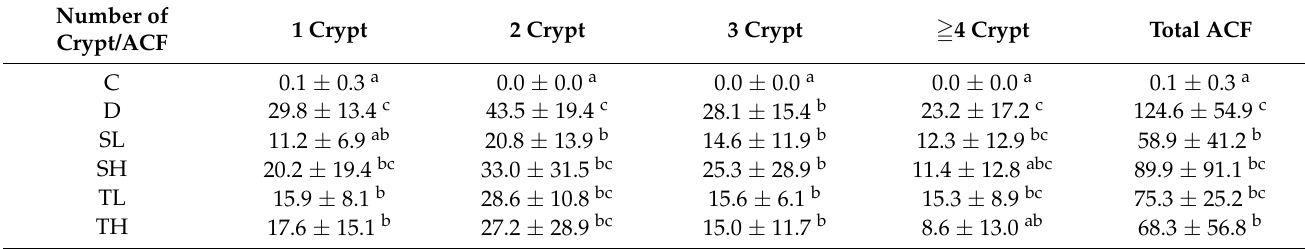
Table 3. Effect of soybeans or tempeh on DMH-induced aberrant crypt foci formation in rat